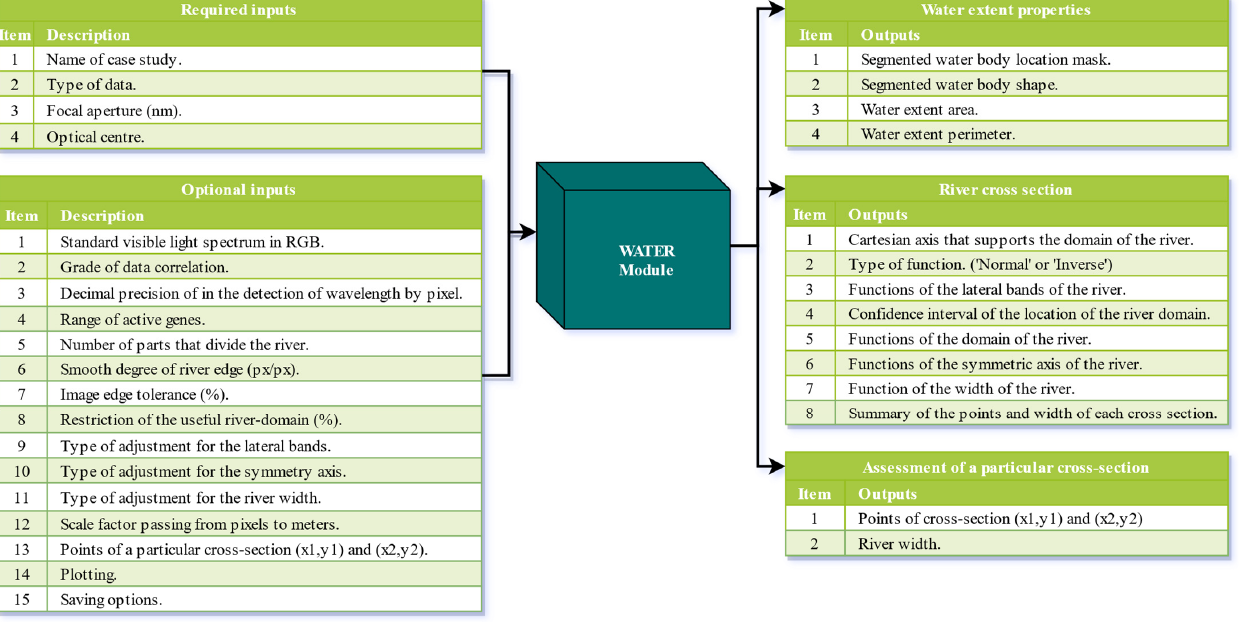
Figure 3. WATER overview with required and optional inputs as well outputs. The reader is referred to Supplementary Material A and B as well as codes for more information regarding the algorithms involved.